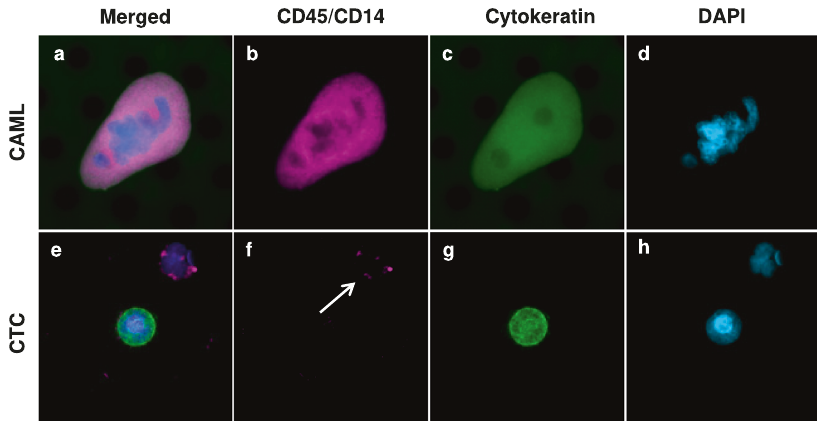
Fig. 1 Images of CAML, CTC, and white blood cell. a – d CAMLs are enlarged cells with a polyploid nucleus (blue), diffuse Cytokeratin (green) and often CD45/CD14 positive (purple). e – h CTCs are cells with nuclei(blue), fi lamented Cytokeratin (green), and are CD45/CD14 (purple) negative. White arrow highlights a normal white blood cell (DAPI and CD45/CD14 positive). Boxes = 75 µm. 0.019) (Fig. 4b). CAML thresholds for CAML number and Largest CAML size, ≥ 12 CAMLs and ≥ 50 μ m respectively, were optimized